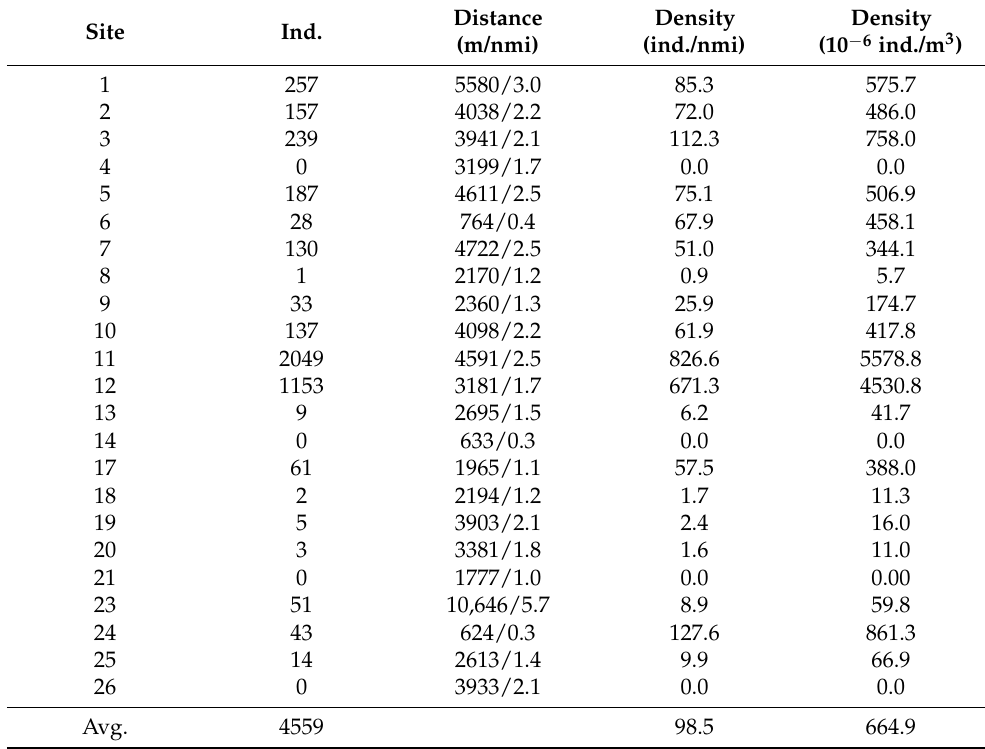
Table 7. Distribution density of jellyfish using the sighting survey method in the Southern Sea and Jeju coastal